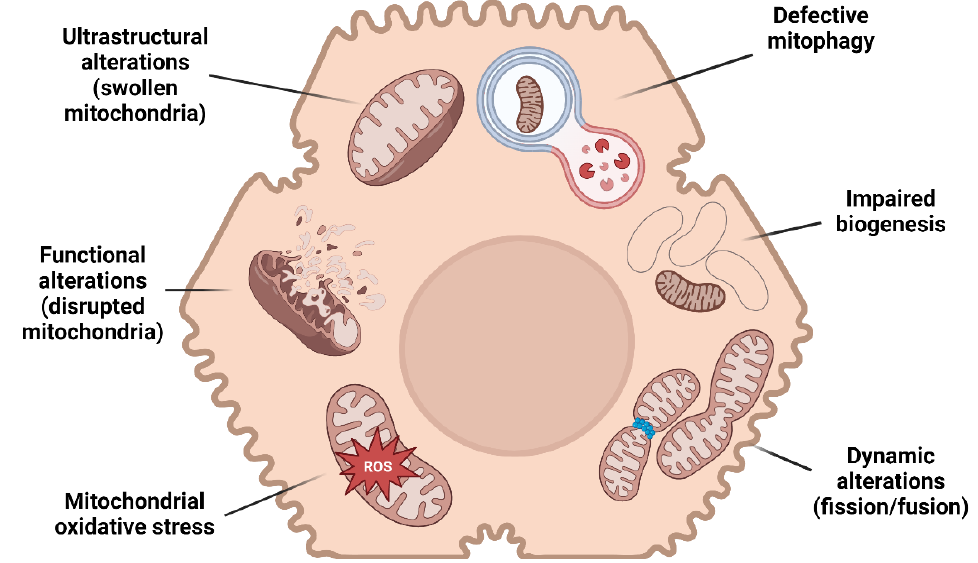
Figure 1. Mitochondrial alterations and MAFLD. A schematic illustration resuming the main mito- chondrial changes in hepatocytes leading to MAFLD.